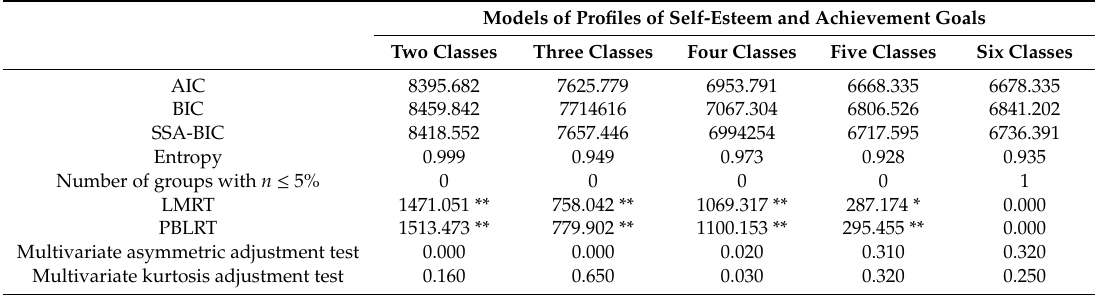
Table 2. Statistics for identifying model adjustment of latent classes and classifying